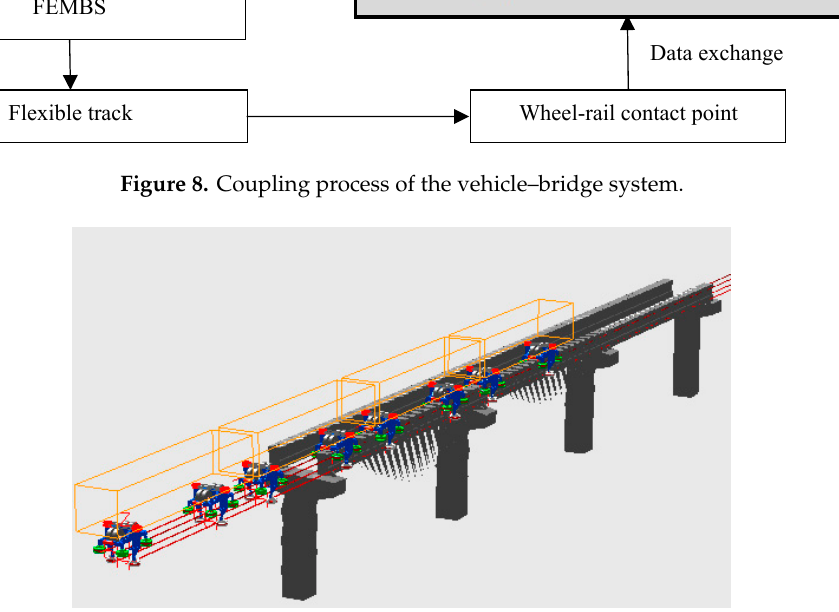
Figure 9. Model of the vehicle–bridge coupled system.